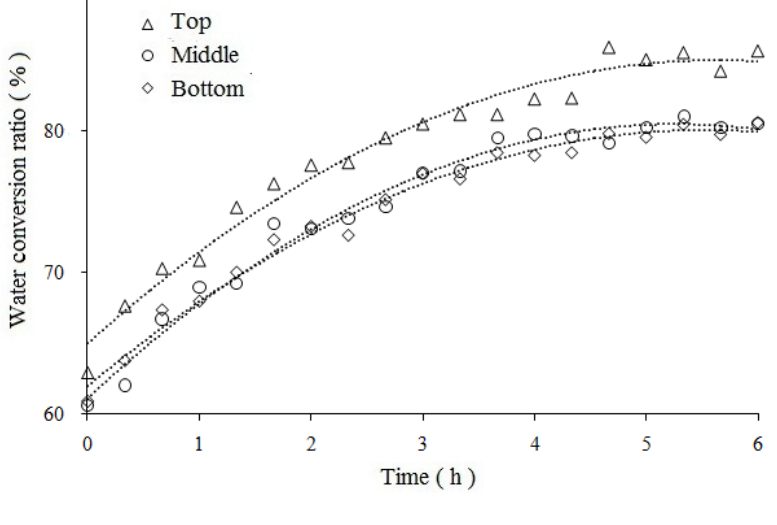
Figure 7. Amplitudes of 9–15 h period in Figure 4 (for the above same reasons, 9 h, 15 h in Figure 4 were respectively translated into 0 h, 6 h. Top: water conversion ratio = −0.0063 × reaction time 2 + 0.0709 × reaction time + 0.6496, R 2 = 0.9756; Middle: water conversion ratio = −0.007 × reaction time 2 + 0.0736 × reaction time + 0.6109, R 2 = 0.9809; Bottom: water conversion ratio = −0.0059 × reaction time 2 + 0.0654 × reaction time + 0.6196, R 2 = 0.9856. Reaction time implies the same as